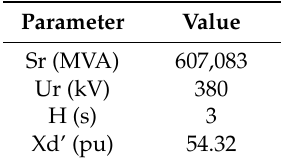
Table A6. Parameters of synchronous machine (Area 2)—classical model.